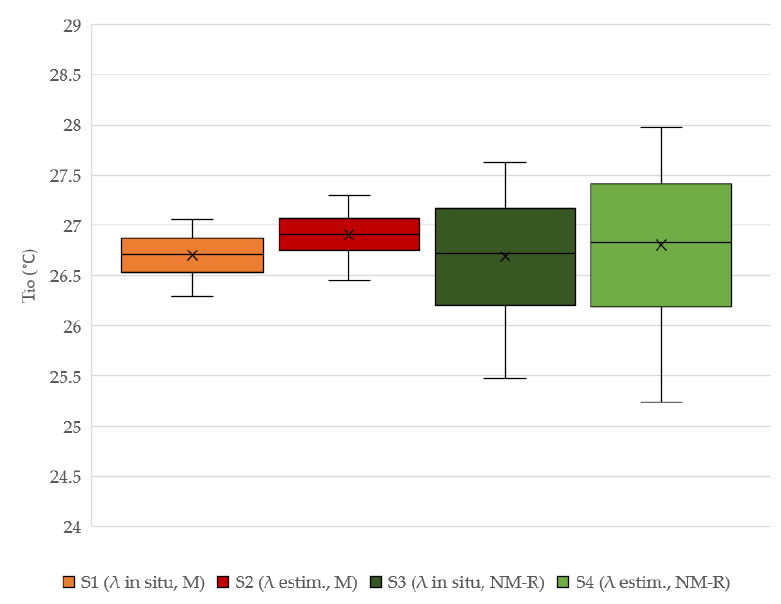
Figure 7. Indoor operative temperature values in simulations (8 – 14 January 2018). No heating devices.